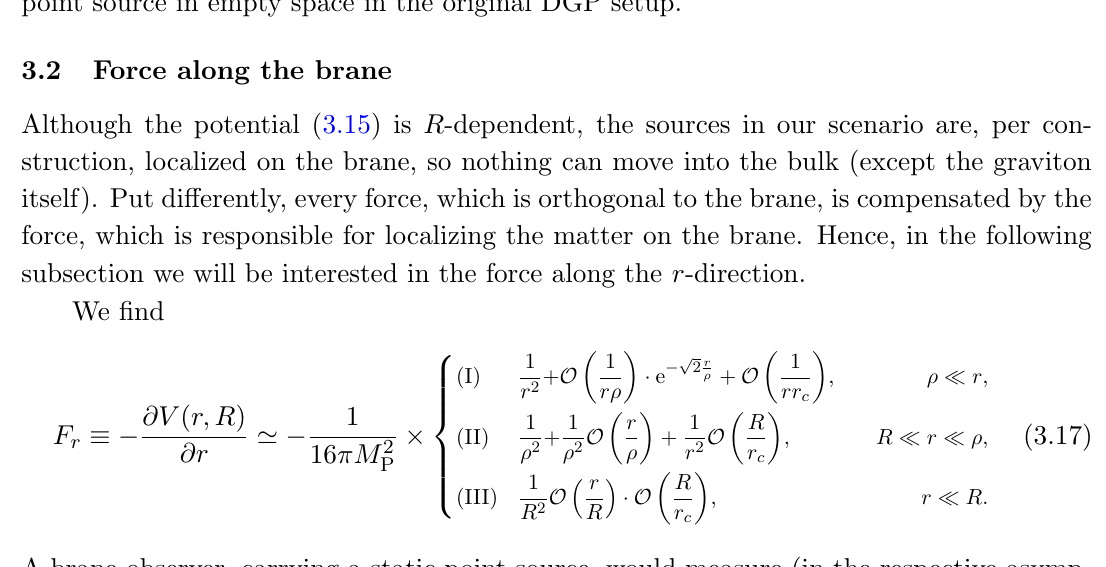
Figure 2. This (linear) plot shows the force F r , expressed in units of G distance along the 3-brane, r , expressed in units of (cid:26) . The force takes di(cid:11)erent asymptotic forms in the regimes r (cid:28) R , R (cid:28) r (cid:28) (cid:26) and (cid:26) (cid:28) r